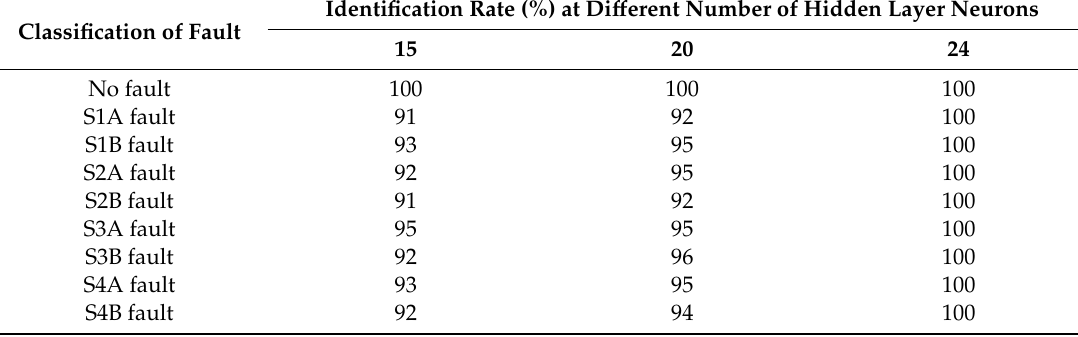
Table 3. Overall Identification rates of FFT-ANN-LabVIEW